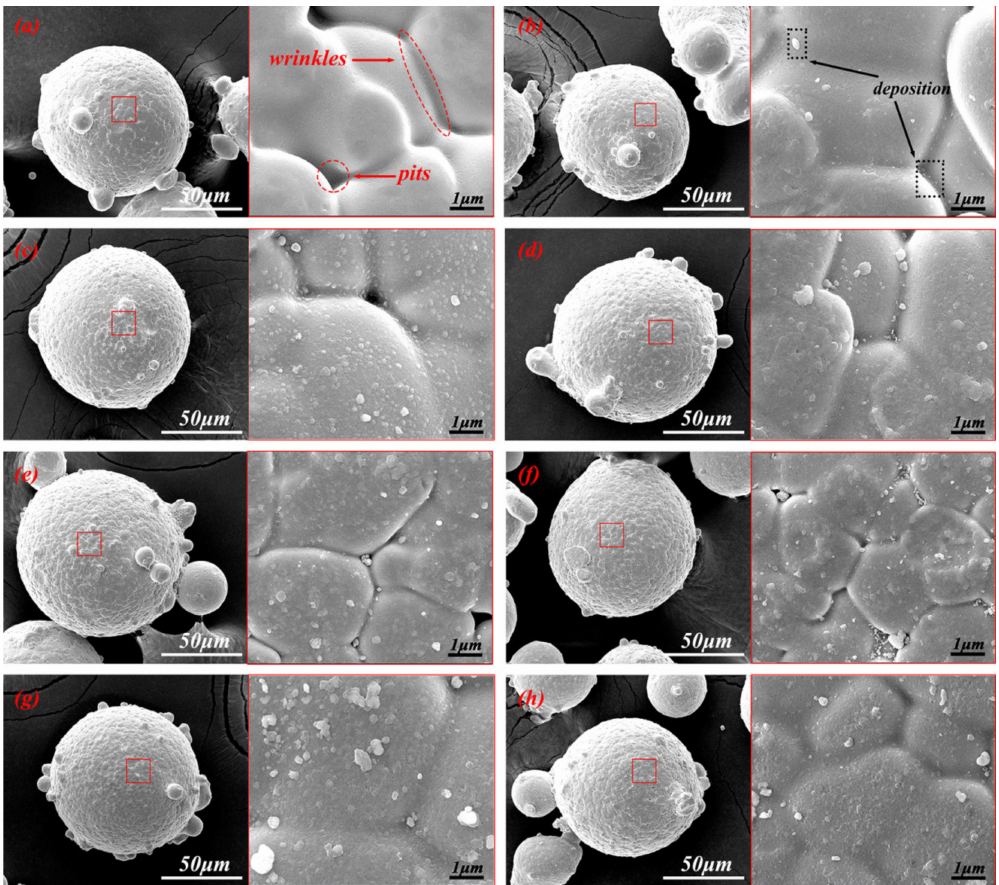
Figure 2. ( a ) Field-emission scanning electron microscope (FE-SEM) images of the original Fe-6.5wt.%Si particles; particle samples following FBCVD for ( b ) 60 s, ( c ) 120 s, ( d ) 240 s, ( e ) 480 s, ( f ) 960 s, ( g ) 1920 s, and ( h ) 3840